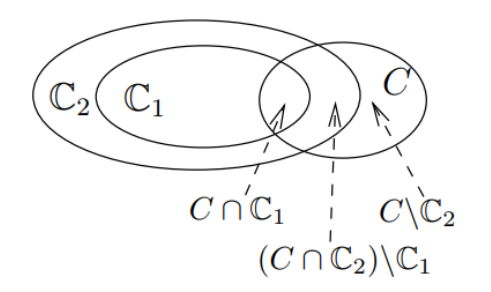
Figure 5. Illustration of the proof of Lemma